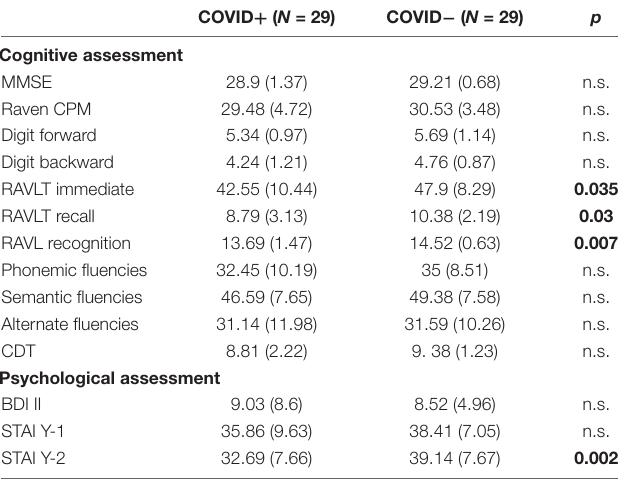
TABLE 2 | Comparisons of the cognitive and psychological assessment scores between COVID + and COVID − groups.